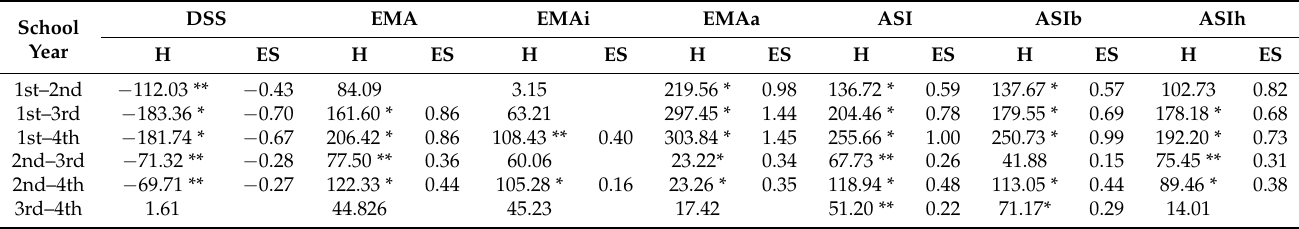
Table 4. Kruskal–Wallis test adjusted with the Bonferroni correction for school year and Cohen’s d.